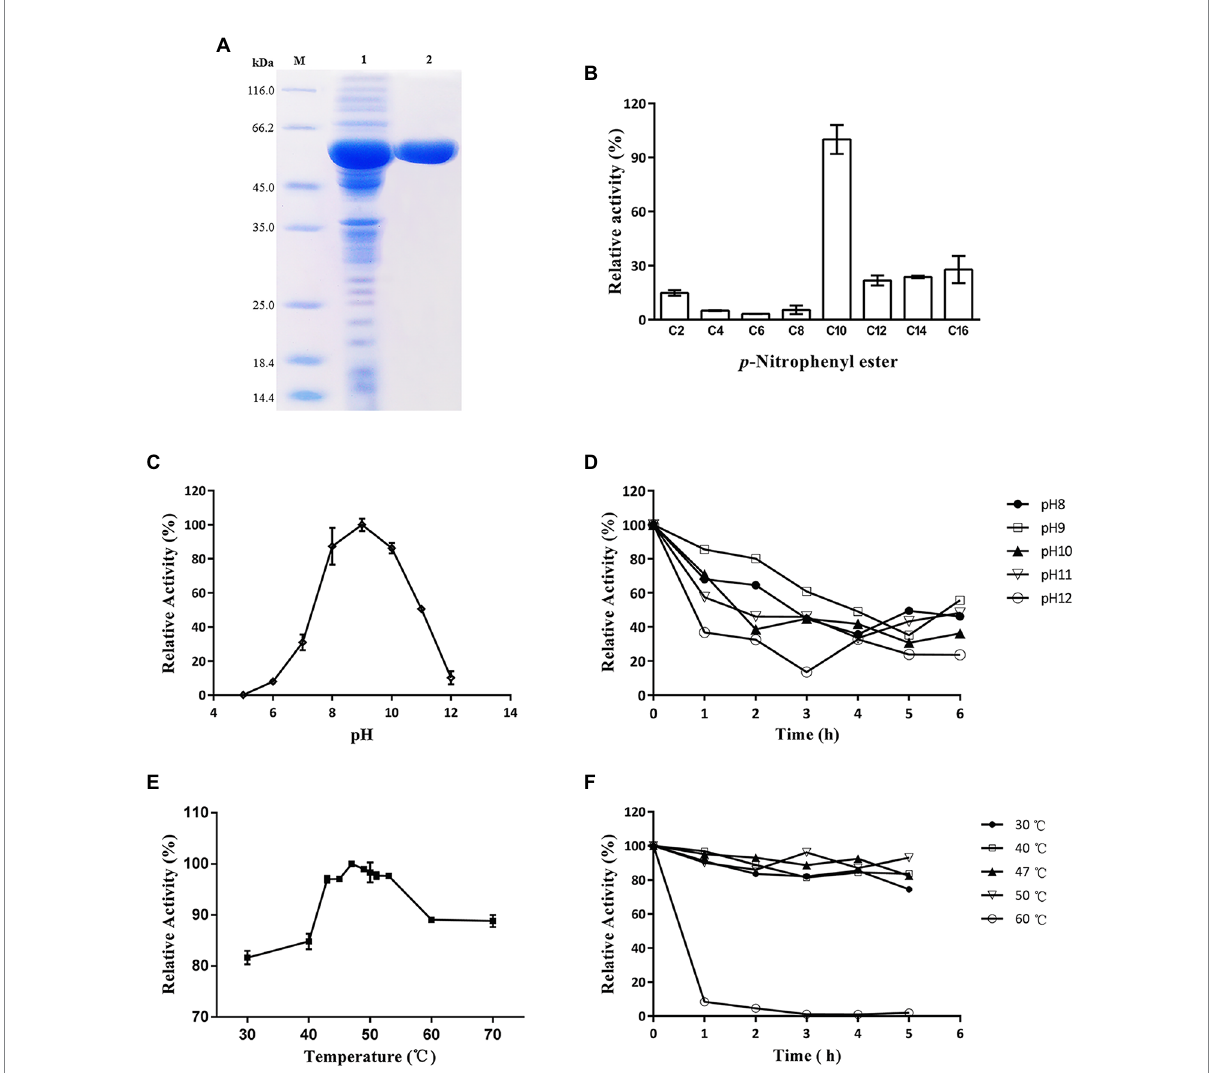
FIGURE 3 SDS-PAGE analysis and characterization of Lip54q. (A) SDS-PAGE analysis of recombinant Lip54q. Lanes: M, standard protein molecular mass markers (size in kilodaltons are indicated on the left;); 1, recombinant Lip54q with his-tag from supernatant of E. coli BL21 (DE3) cell lysates; 2, purified recombinant Lip54q with his-tag by affinity chromatography. The target protein band was indicated by arrow. (B) Substrate specificity analysis of Lip54q. The enzymatic activity of Lip54q was examined toward p -nitrophenol esters with different chain lengths: p -nitrophenyl acetate (C2), p -nitrophenyl butyrate (C4), p -nitrophenyl caproate (C6), p -nitrophenyl octanoate (C8), p -nitrophenyl decanoate (C10), p -nitrophenyl laurate (C12), p -nitrophenyl myristate (C14), p -nitrophenyl palmitate (C16). The activity of Lip54q toward C10 was regarded as 100%. Data are the average of triplicate experiments, and error bars represent standard deviation. (C) Effects of pH on Lip54q activity using p -nitrophenyl decanoate as the substrate. Enzymatic activity was measured in 40 mM Britton-Robinson buffer (pH 5.0–12.0) at 45 ° C. Values are shown as the percentage